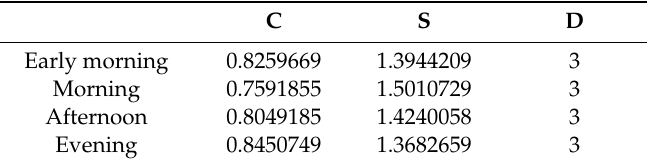
Table 3. The average cluster coe ffi cient (C), average path length (S), and diameter (D) of SINB on